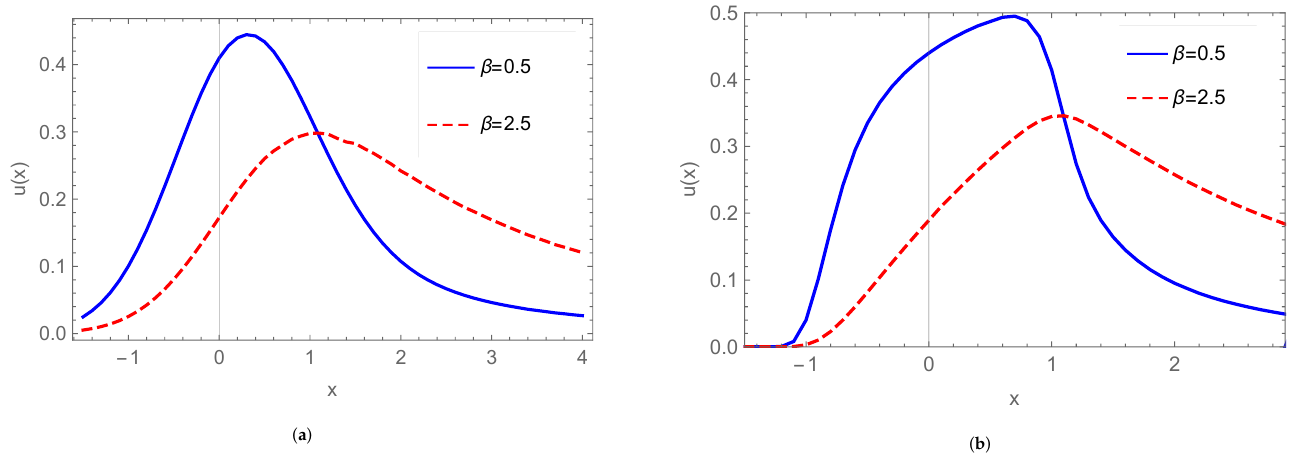
Figure 5. Equation (29) for different values of β , ν = 1 f ( x ) = e − x 4 .